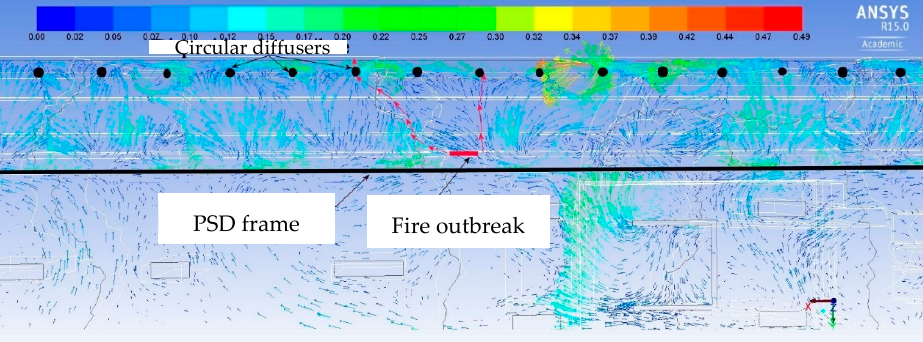
Figure 29. Air velocity vectors (m/s)—longitudinal section between the subway train and the ceiling (minute 20).